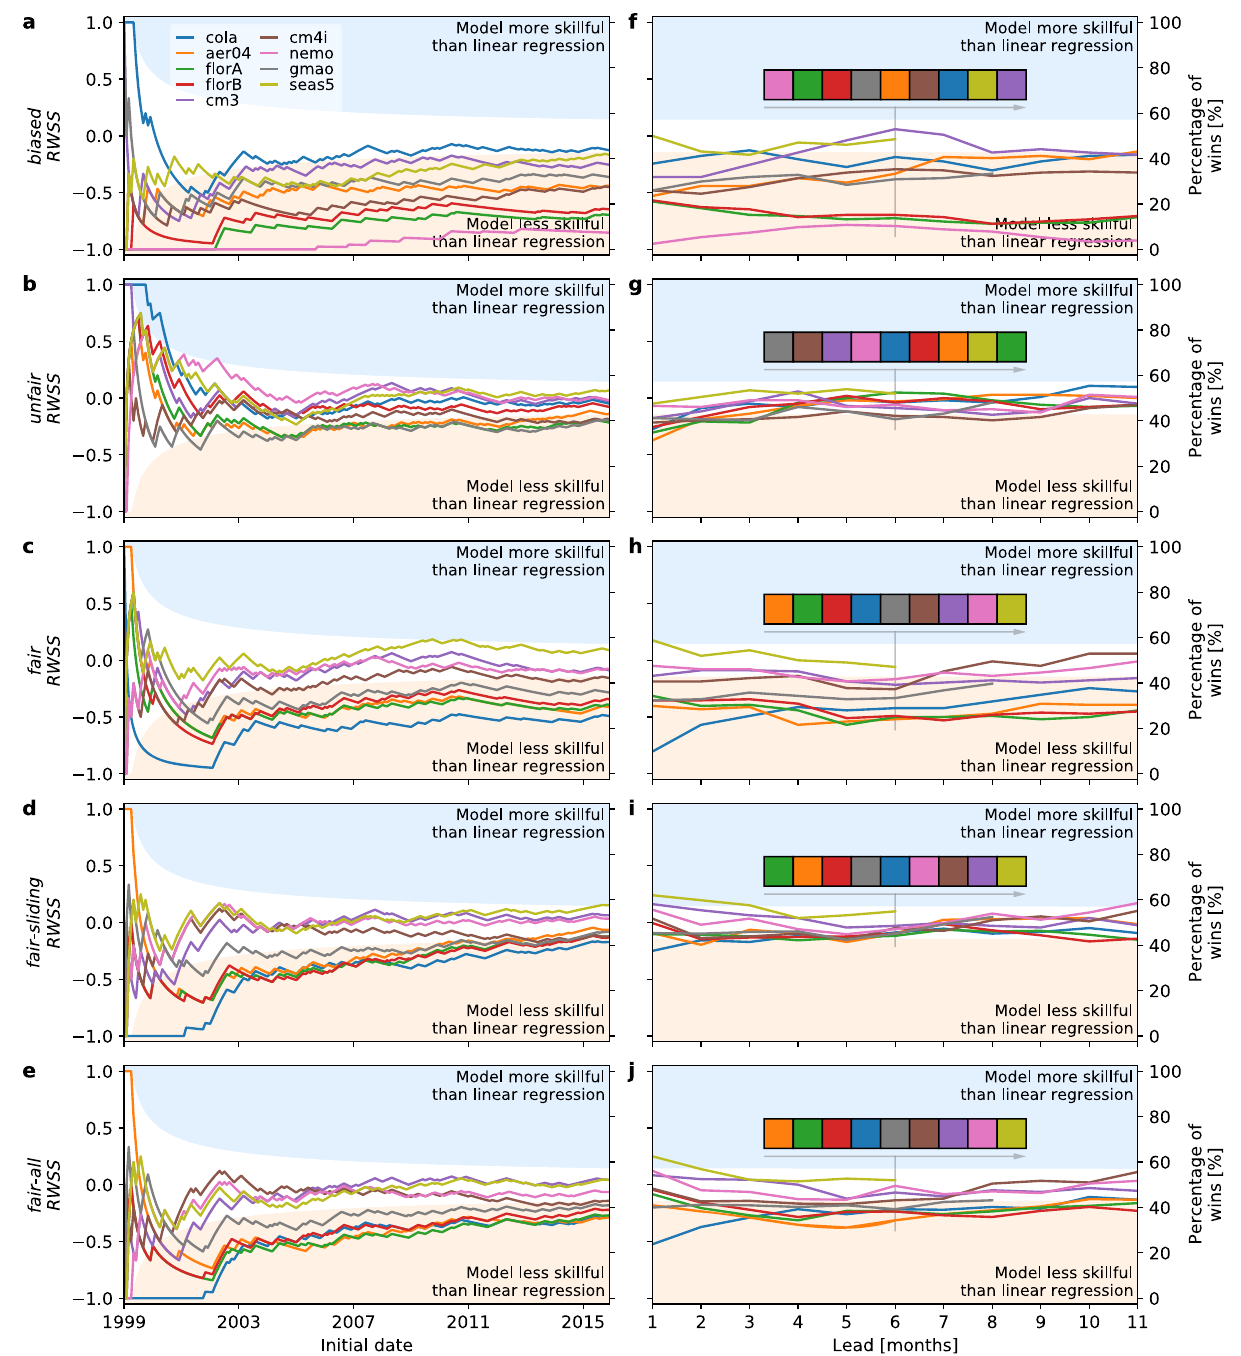
Fig. 2 Skill relative to linear regression. Dynamical model Niño3.4 random walk skill score ( RWSS ) at lead 3 months relative to linear regression model using the methods: biased , unfair , fair , fair-sliding , and fair-all in panels ( a – e ). Forecasts are for the period 1999 to 2016. The white shaded area is an envelope encompassing the RWSS that would be obtained 95% of the time for coin toss trials. The blue shaded area indicates regions where a given dynamical model would be closer to observations than the regression model more often than expected due to chance. The tan region is the converse where the regression model is more often closer to observations than the dynamical model than expected by chance. The RWSS can vary between − 1 (model always less skillful than regression), 0 (model and regression equally skillful), to 1 (model always more skillful than regression). This score can also be expressed as the percentage of wins for the dynamical model (right vertical axis). The panels ( f – j ) show the fi nal value of the random walk skill score, RWSS n , for lead times from 1 – 11 months. The coloured boxes in panels ( f – j ) are ordered to show the model rankings relative to linear regression at lead 6, going from least skillful on the left to most skillful on the right. The colour code for the models is given in the legend in panel a . For skill relative to logistic regression, see Supplementary Note